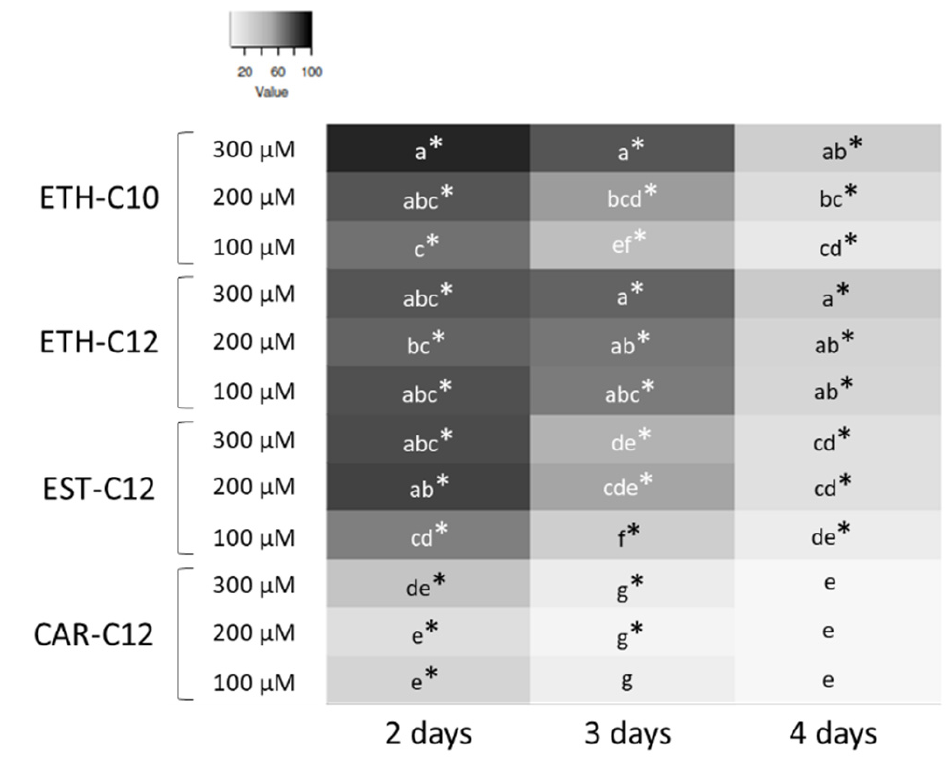
Figure 4. Heat map of B. cinerea growth inhibition (%—in comparison with the control DMSO 0.1%) after 2, 3 and 4 days of growth in presence of smRLs (Eth-C10, Eth-C12, Est-C12 and Car-C12) added in wells of microplates before conidia inoculation. In each column, * indicates significant growth inhibition in comparison to the DMSO 0.1% control, and lower-case letters indicate significant di ff erence among the presented means, according to an ANOVA followed by a Tukey-HSD post-hoc test ( p ≤ 0.05). When the solid medium was supplemented with smRLs before inoculation with conidia of B. cinerea , all treatments significantly reduced in vitro growth of the pathogen after 2 days (Figure 4). After 3 and 4 days, the percentage of growth inhibition decreased for all the treatments, irrespective of the applied concentration. The greatest growth reduction was obtained with Eth-C10 and Eth-C12 at 300 µ M. On the contrary, no or little reduction in growth was observed at 3 and 4 days with Car-C12. As Car-C12 did not show a strong e ff ect on the conidial germination and subsequent mycelial growth, it was not considered for the dual-test on mycelium that had been actively growing for 1 day. The e ff ects of Eth-C10, Eth-C12, and Est-C12 monitored on the growth of a mycelium that had been actively growing for 1 day are presented in Figure